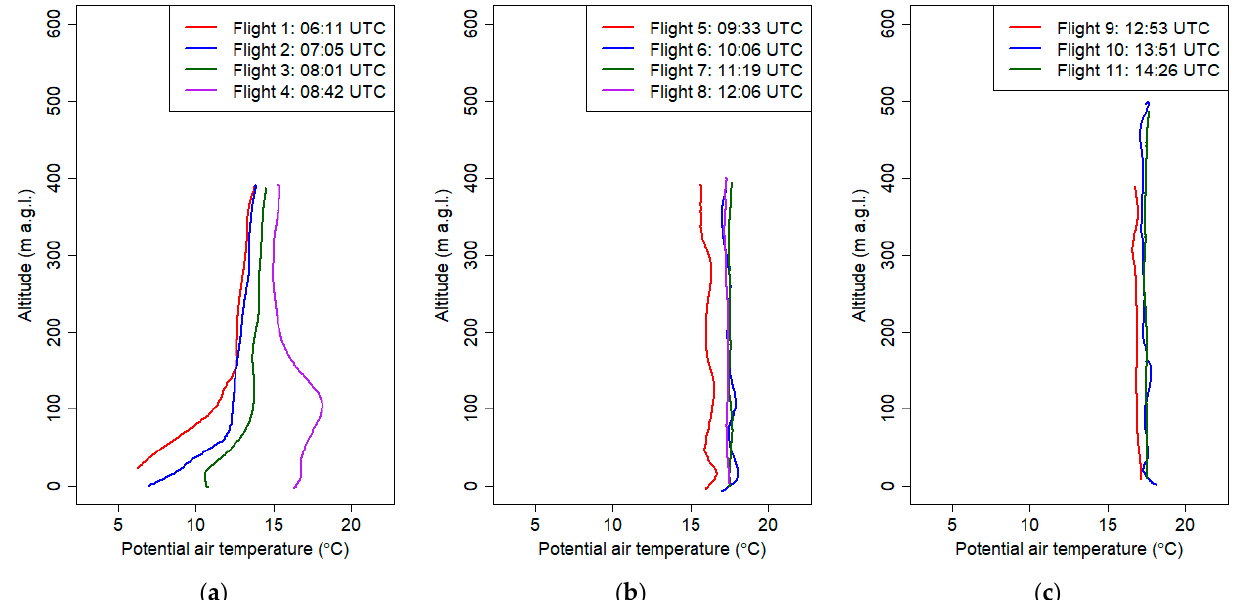
Figure 15. Vertical profiles of potential temperature on March the 7th, 2019 from 6:00 UTC to 15:00 UTC.